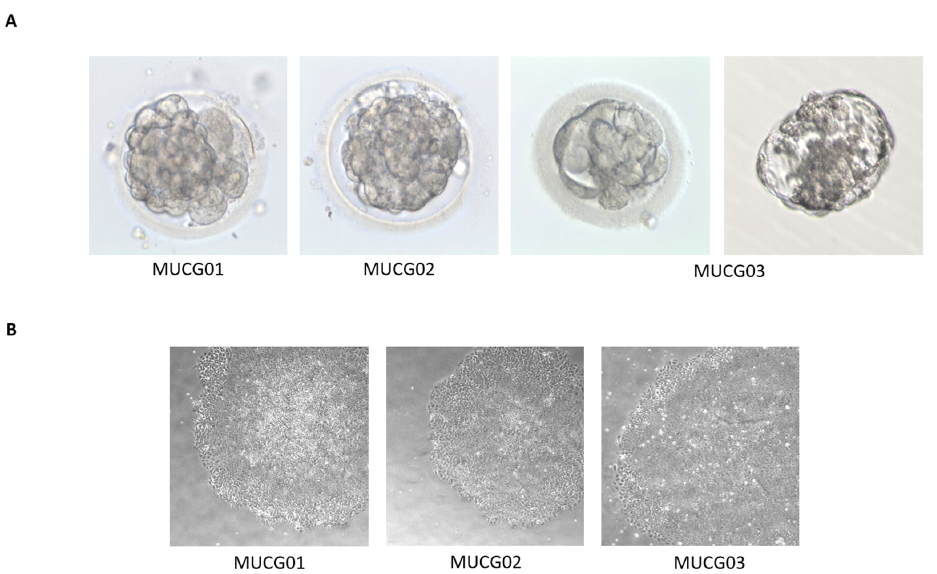
Figure 2. ( A ) Blastocysts used for the derivation of clinical-grade hESC lines MUCG01, MUCG02 and MUCG03. Blastocyst for the derivation of MUCG03 was cultured for two days before transport;